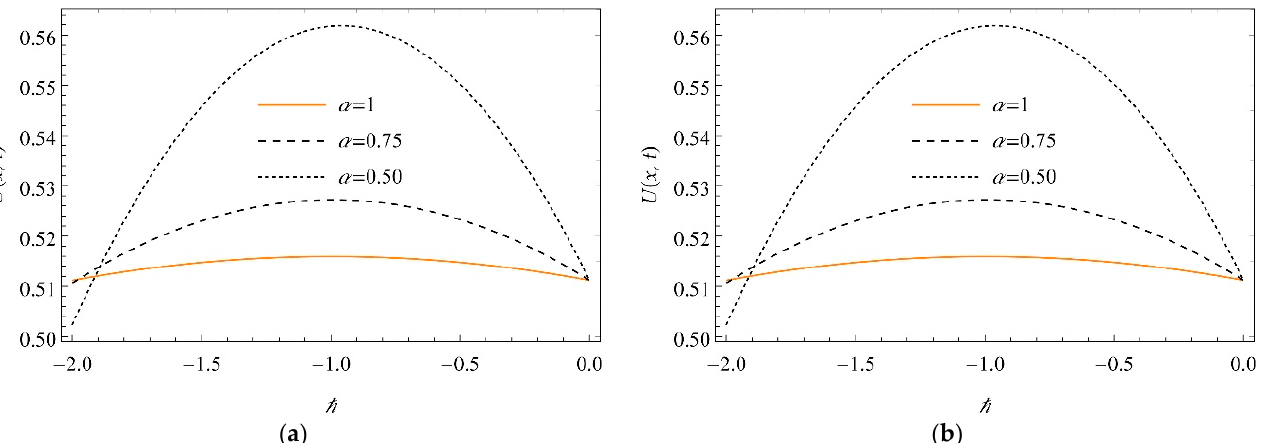
Figure 11. The sketch of ℏ -curve profiles for the 𝑈 against ℏ for Equation (37) at ( a ) 𝑛 = 1 and ( b ) 𝑛 = 2 when 𝑡 = 0.01, 𝑥 = 0.5 for diverse values of 𝛼 .